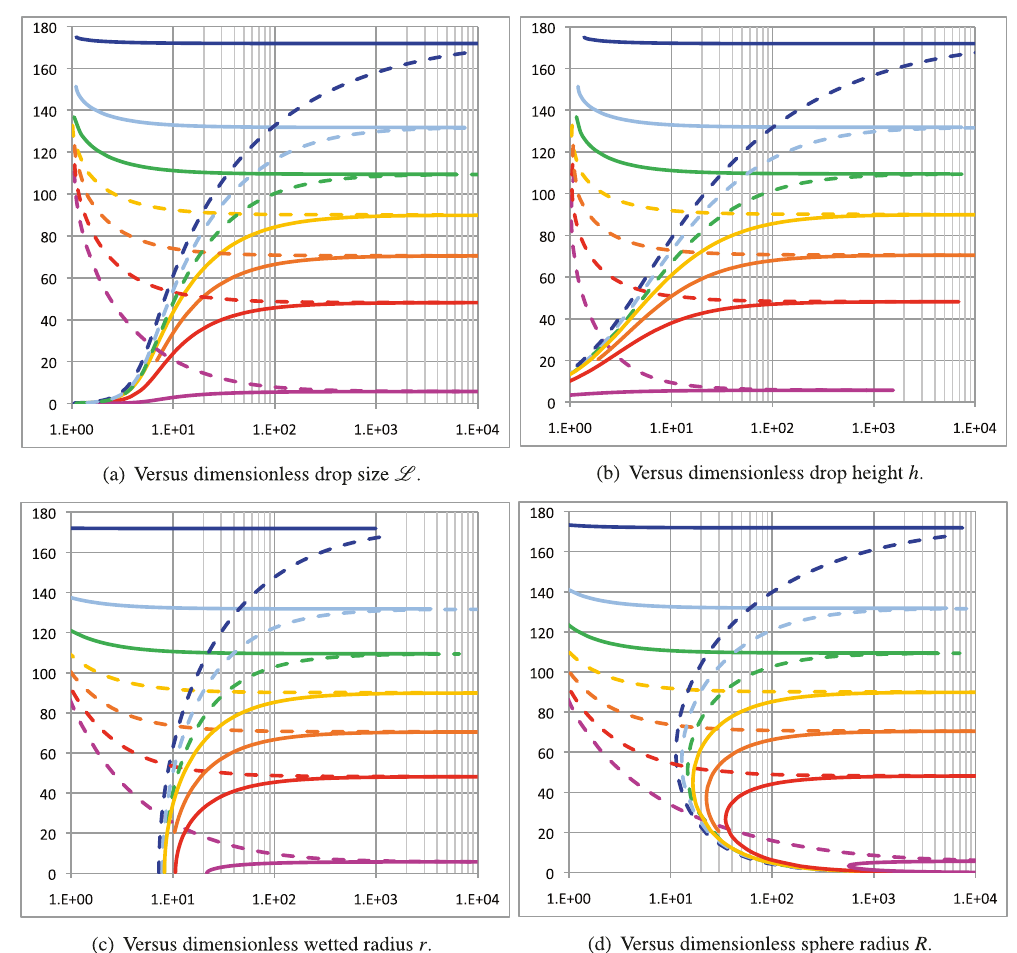
Fig. 2 Macroscopic contact angle versus dimensionless geometrical quantities ( L , h , r and R ), for S ¼ (cid:2) 0 : 99 (blue), − 2/3 (cyan), − 1/3 (green), 0 (yellow), 1/3 (orange), 2/3 (red) and 0.99 (magenta). a versus dimensionless drop size L ; ( b ) versus dimensionless drop height h ; ( c ) versus dimensionless wetted radius r ; ( d ) rersus dimensionless sphere radius R